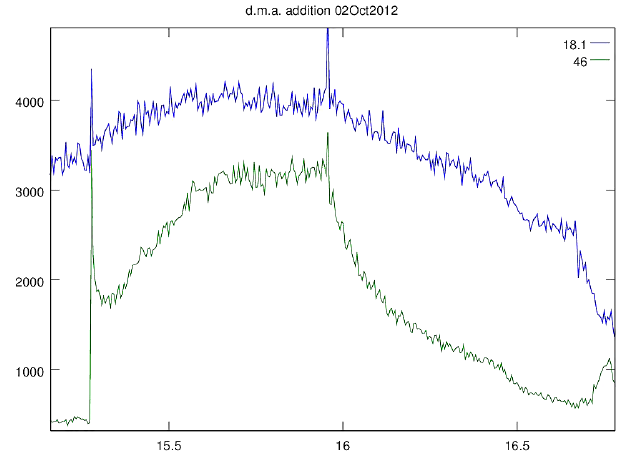
Figure 3. Temporal plot (h) of dimethylamine (M · H + at 46u) and ammonia (18u) mixing ratios before, during and after addi- tion of dimethylamine to AmPMS. The drift region had not been cleaned after the Lewes campaign. A zero was initiated at 16.45h and AmPMS began to sample another stream of air beginning at 16.7h.